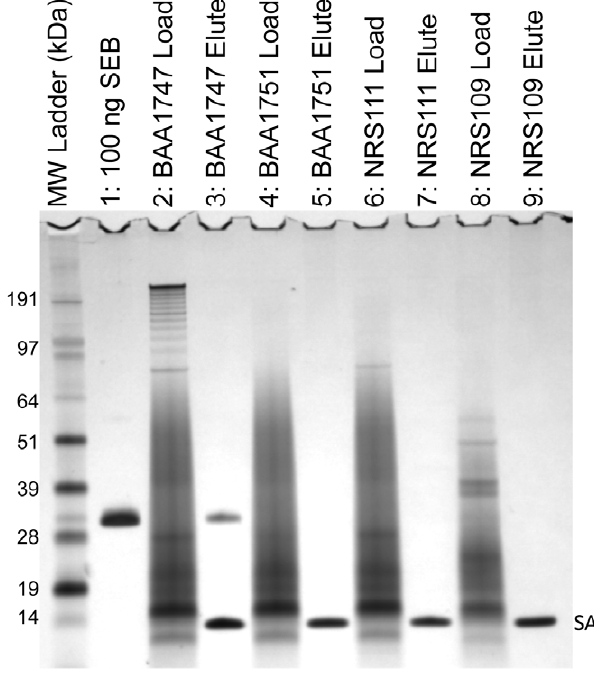
Figure 3. APT SEB1 is selective for SEB within a complex mixture. The toxin-rich cell-free culture supernatant from four S. aureus strains was assayed for the presence of SEB by aptamer-precipitation. Five microliters of each culture supernatant was loaded onto an 4–12% SDS- PAGE gel to determine the protein content (lanes 2, 4, 6, 8). Three milliliters of each culture supernatant was incubated with APT SEB1 - coated Dynabeads. After washing with PBS-T, the resultant protein eluate from the APT SEB1 -coated Dynabeads was analyzed (lanes 3, 5, 7, 9). By PCR and ELISA analysis (Sandra Tallent, personal communication) the four strains potentially express a total of 17 enterotoxins and toxic shock syndrome toxin. However, only strain BAA1747 contains the gene for SEB. The protein bands labeled as ‘‘SA’’ represent the monomer of streptavidin liberated by the elution protocol.